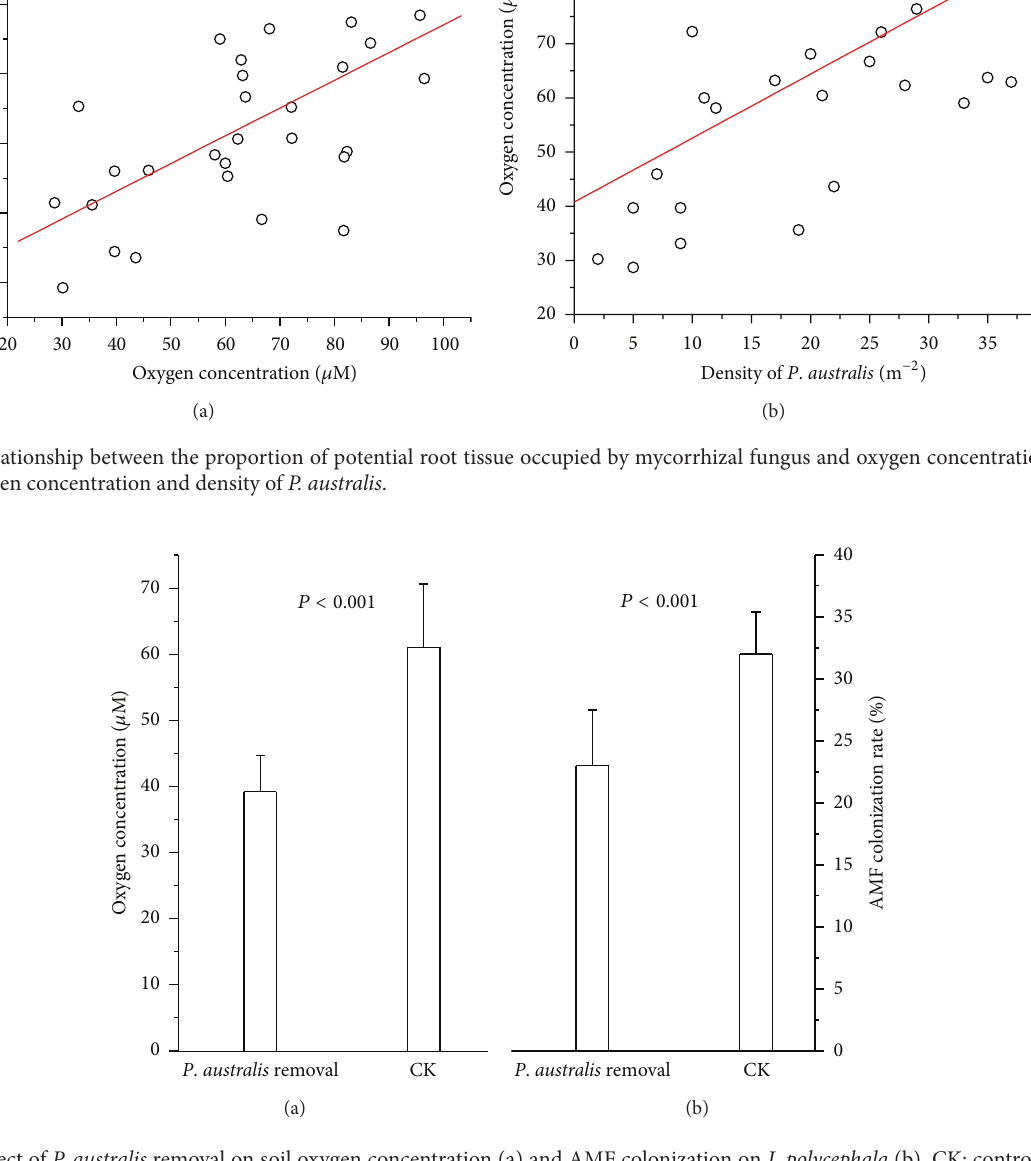
Figure 4: Effect of P. australis removal on soil oxygen concentration (a) and AMF colonization on I. polycephala (b). CK: control. 𝑃 values are from t -test between fungicide application and no fungicide